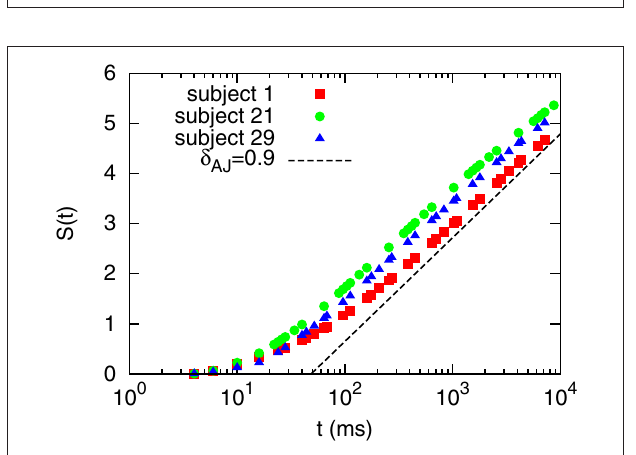
FiGuRE 3 | Avalanche size distribution, averaged over subjects, for different montages.